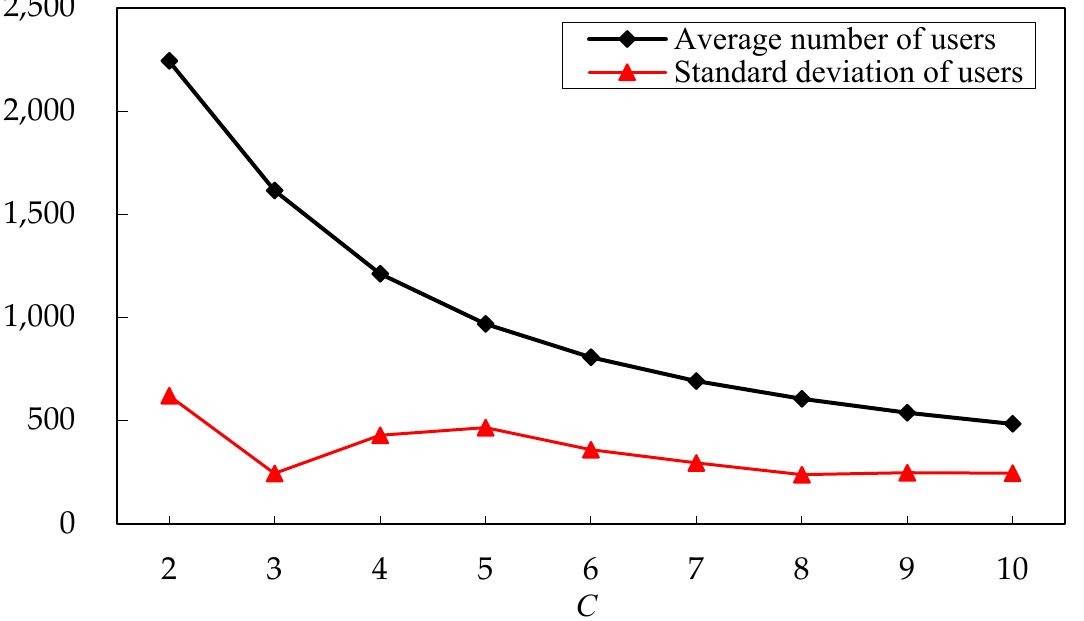
Figure 7. Average number of users and standard deviation of users.